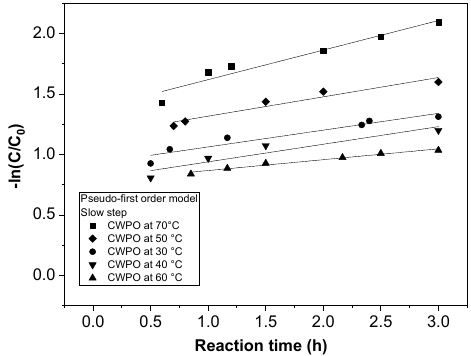
Figure 4. − ln( C / C 0 ) versus reaction time plot at different temperatures.